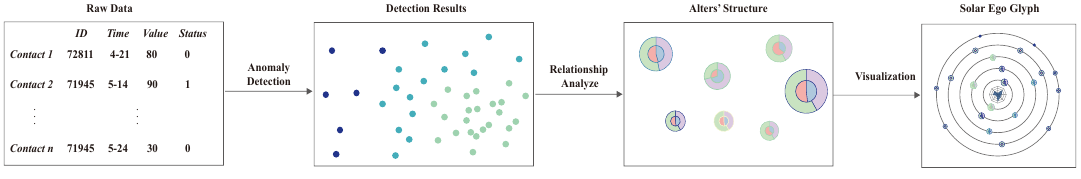
Figure 2. Workflow of the solar ego